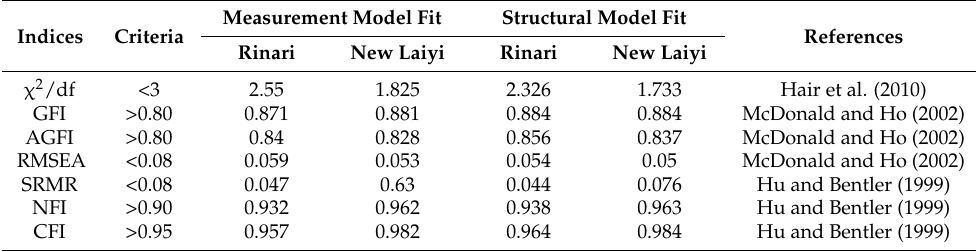
Table 2. Goodness of fit.